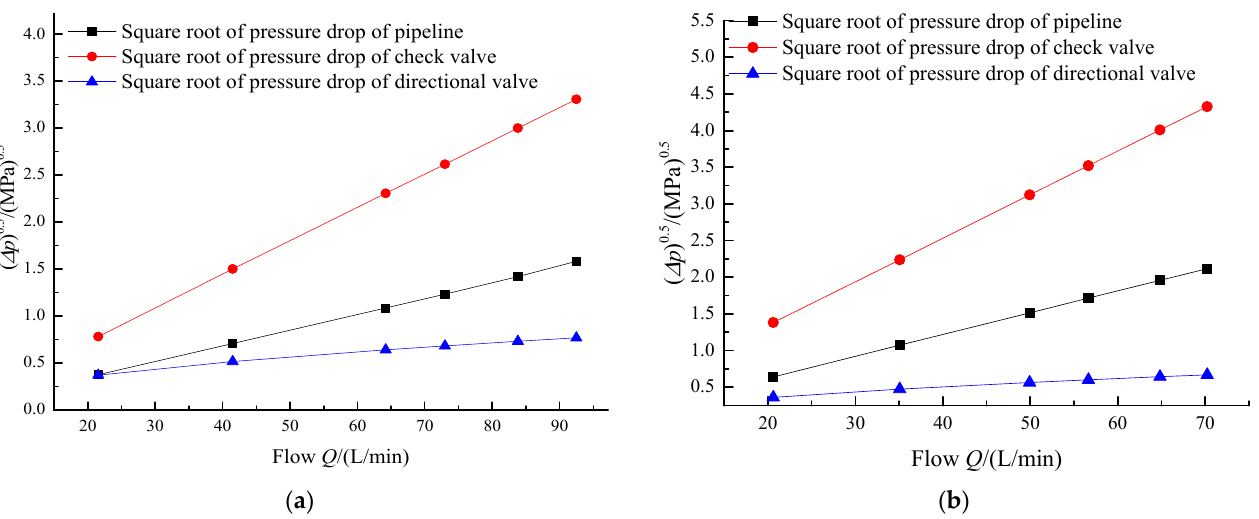
Figure 9. The relationship between flow and square root of differential pressure at all levels when the hydraulic cylinder is operated under DN10 pipeline diameter: ( a ) retracted; ( b ) extended.